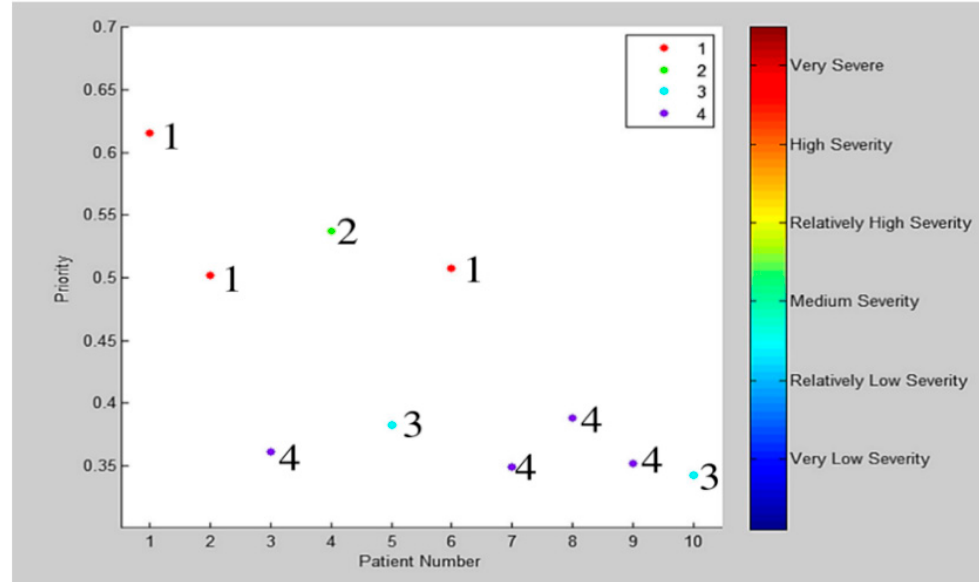
Figure 3. Patients priority (the number next to each point represents the patient group) [45].